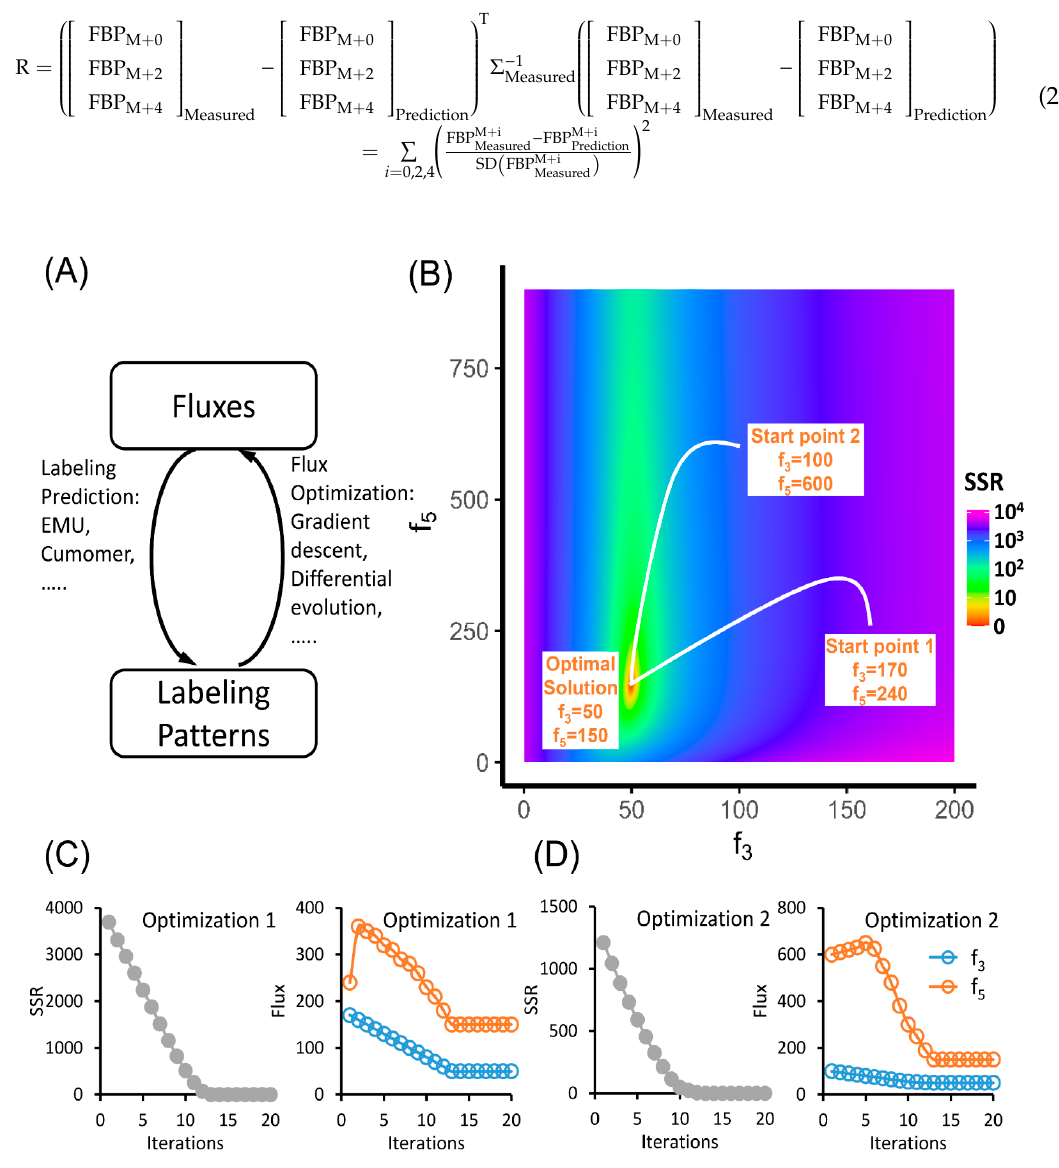
Figure 2. The solving process of MFA. ( A ) The relationship between fluxes and labeling patterns. The choice of tracer and fluxes can determine the labeling patterns, which can be calculated by elementary metabolite units (EMU), cumomer or other methods. The flux-solving process is the inverse problem of the labeling prediction, which involves iterative fitting between the labeling pattern predicted from “guessed” fluxes and the observed labeling pattern. ( B – D ) Iterative paths of optimization from two different start points ending with the same solution. ( B ) The landscape plot of sum of squared residuals (SSR) on the plane of free fluxes. Each dot on this plane represents a combination of fluxes, which gives a prediction on the labeling pattern of FBP. This predicted labeling pattern is compared to the measurement and the discrepancy between them is defined as the SSR and is plotted with different colors on the plane. For flux calculation, we can start from a random point and perform gradient descent or other optimization algorithms to minimize the SSR. The iterative paths starting from two randomly chosen points are shown. ( C , D ) Change of SSR and fluxes from start point 1 ( C ) and 2 ( D ) to the optimal solution.